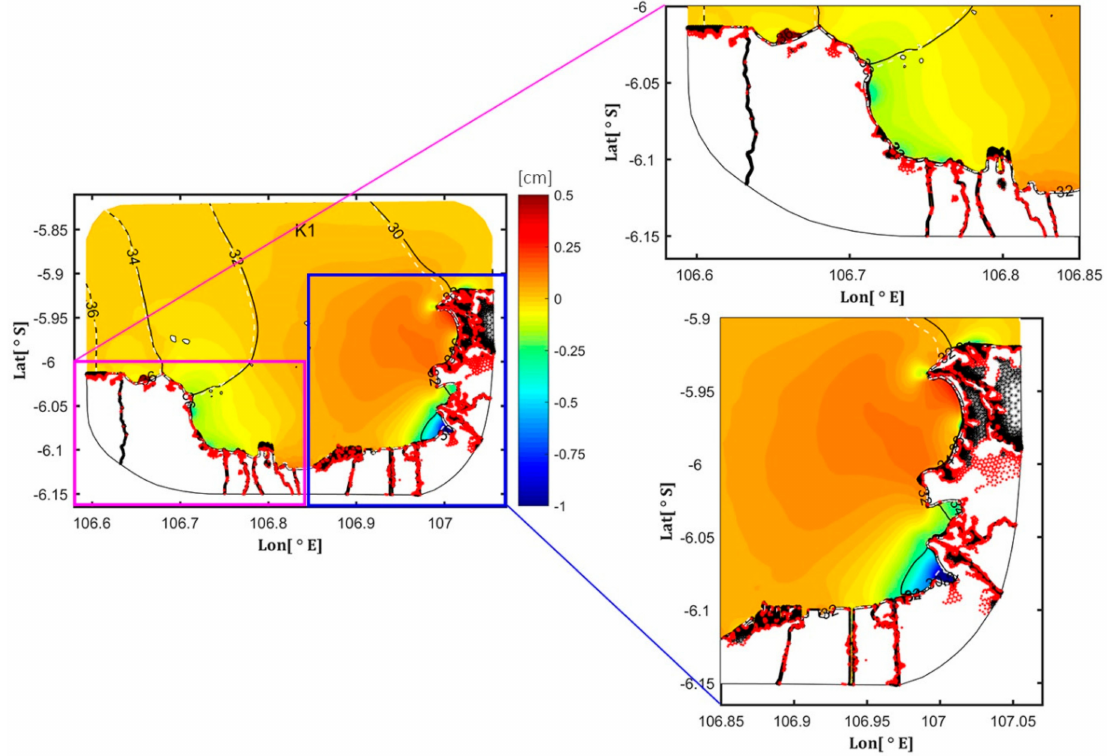
Figure 9. Changes in K1 tidal amplitudes (cm) and inundation areas in Jakarta Bay between scenario 2b and scenario 1. Black dots indicate the inundation area in scenario 1, and red dots indicate the increased inundation area in scenario 2b. Color contours indicate the changes in K1 amplitude